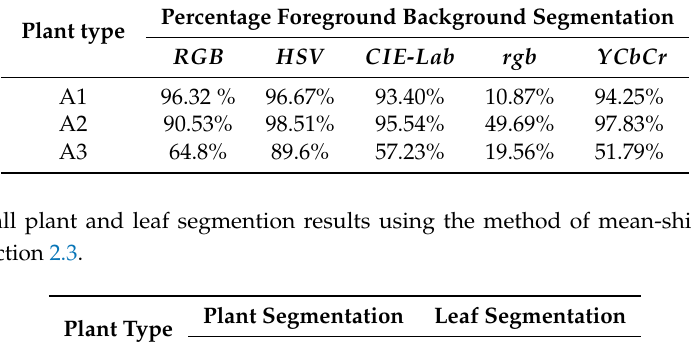
Table 3. Percentage foreground background segmentation results in the different colour spaces for there different datasets. A1’s are Arabidopsis plants with a red background, A2’s are Arabidopsis plants with black background and A3’s are tobacoo plants imaged in controlled growth chambers.